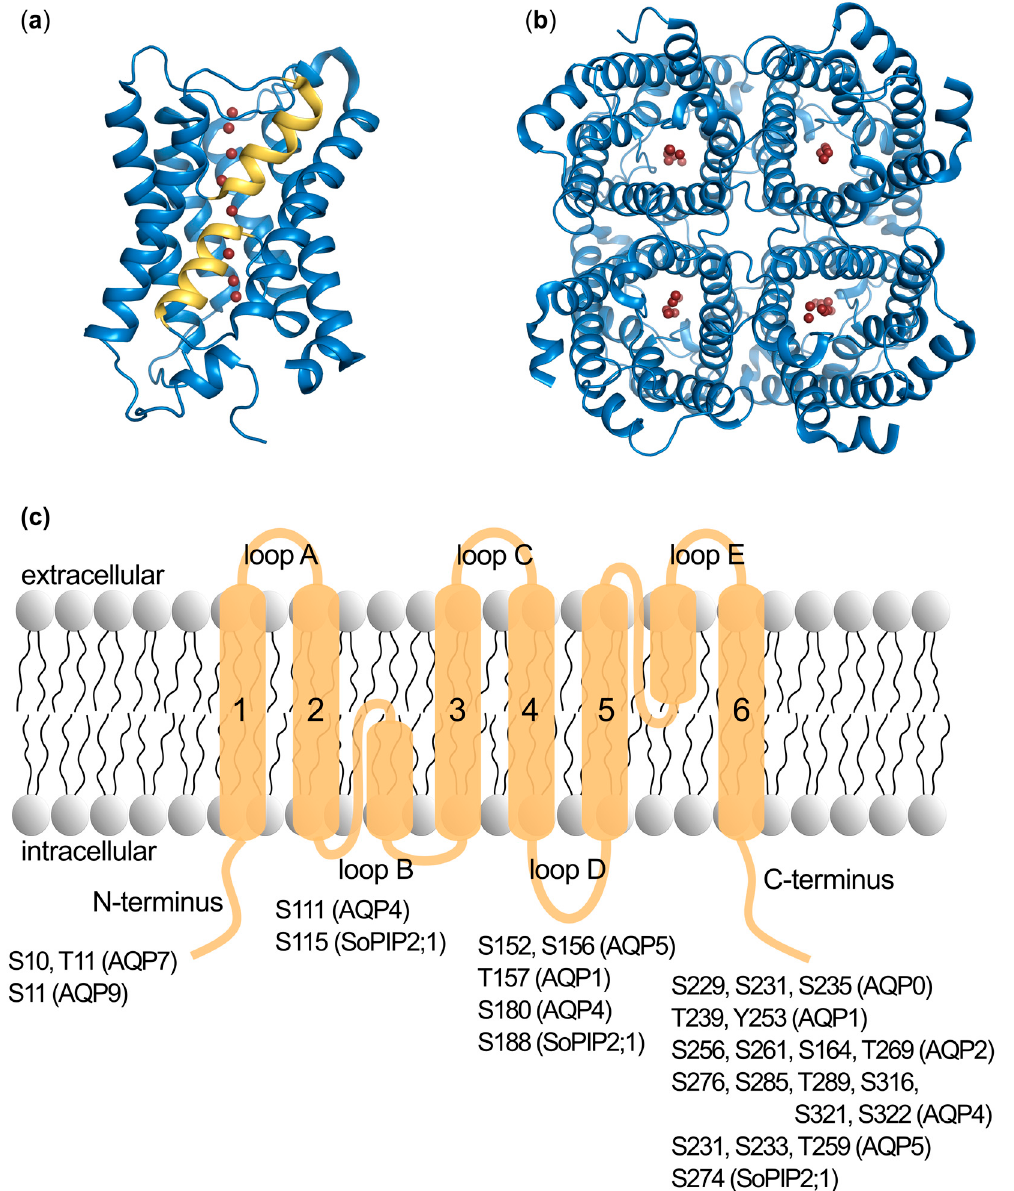
Figure 1. The overall structure of aquaporins and the localization of individual phosphorylation sites. ( a ) Side view of the aquaporin monomer represented by the crystal structure of human AQP5 (PDB 3D9S). Water molecules in the water-conducting pore are marked as red spheres. The two half-helices formed by loops B and E are coloured yellow. ( b ) The tetrameric assembly from the cytoplasmic side. ( c ) A schematic representation of the aquaporin topology with all phosphorylation sites identified in mammalian aquaporins as well as the spinach aquaporin SoPIP2;1 marked.